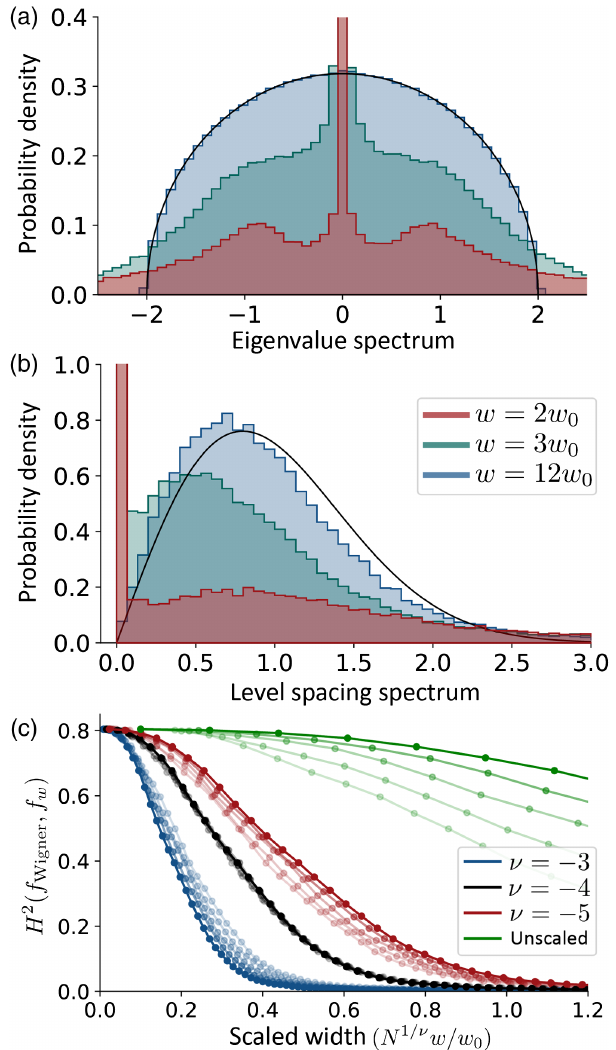
FIG. 6. Eigenvalue spectrum of the CCQED connectivity, demonstrating random matrix statistics. (a) The eigenvalue distribution f and (b) level-spacing spectrum for the nonlocal w =w 2 0 Þ . N ¼ 1000 spins are cos ð 2 r · r interaction matrix J ij ¼ i j averaged over 50 realizations of J matrices. The distributions ij are shown for w ¼ 2 w 0 (red), w ¼ 3 w 0 (green), and w ¼ 12 w 0 (blue). Each distribution is normalized to have unit variance. The solid black lines show the Wigner semicircle eigenvalue distri- bution (a) and the Wigner surmise for the level-spacing distri- bution of Gaussian orthogonal ensemble random matrices (b). (c) shows the Hellinger distance between the averaged CCQED connectivity eigenvalue distribution f [shown in (a)] and the w Wigner semicircle distribution f . The distance is plotted as a Wigner function of the rescaled width N 1 = ν w=w 0 for different power laws ν ¼ − 3 ; − 4 ; − 5 corresponding to different colors, as indicated. Lines of varying intensity correspond to different N ranging from N ¼ 100 (faintest) to N ¼ 1000 (darkest). The traces overlap well for the ν ¼ − 4 scaling.